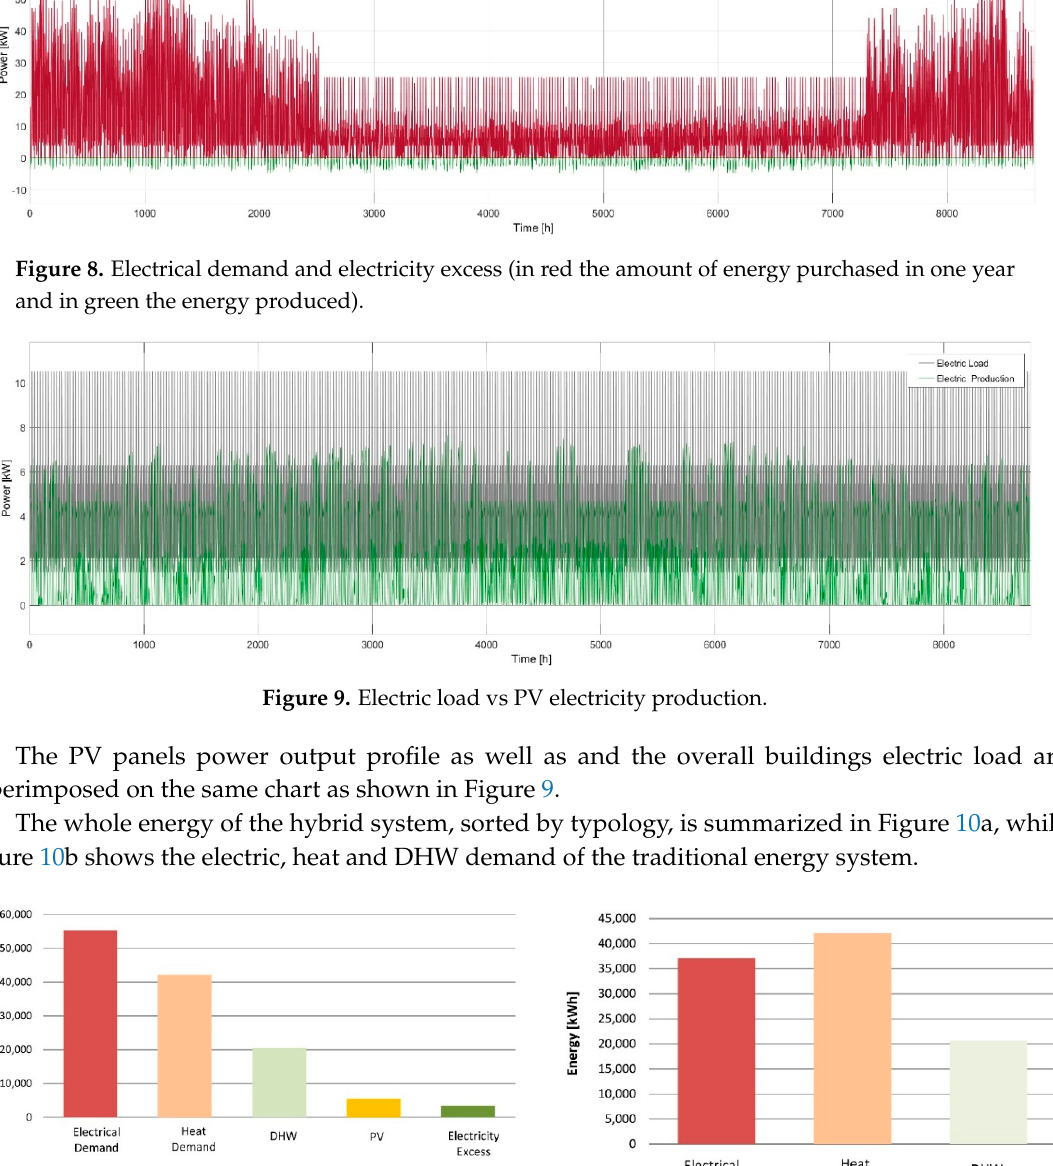
Figure 10. Total energy produced in the hybrid energy system ( a ) and in the traditional energy